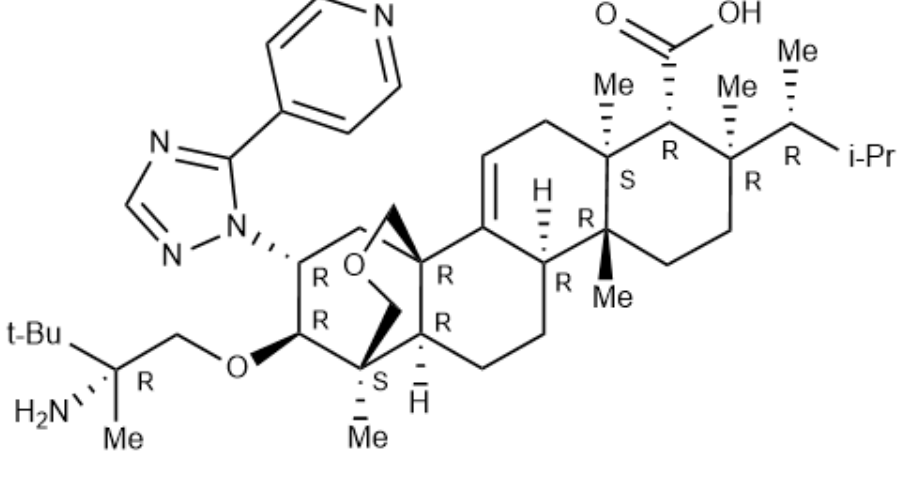
Figure 1. Structure of